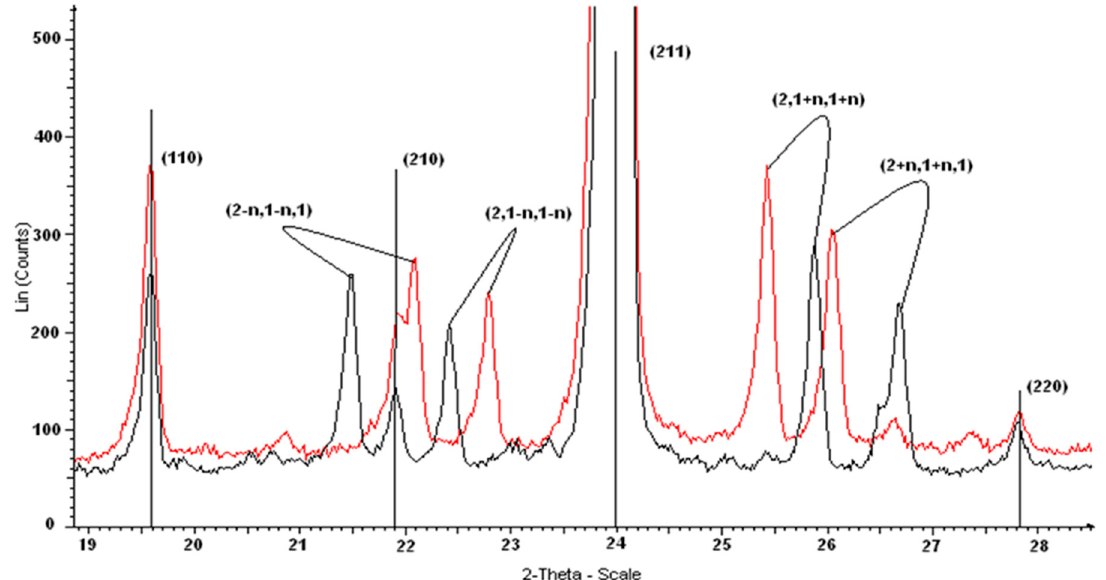
Figure 16. Fragments of the powder X-ray di ff raction patterns of the samples KL (upper curve) and MD (lower curve). The (1 1 0), (2 1 0), (2 1 1), and (2 2 0) reflections of these samples (indicated by vertical lines) have close d values because of close values of their cubic pseudo-cell parameters. Satellites having identical hkl indices with n (cid:44) 0 (those shown with curves) do not coincide because of di ff erent values of the n parameter (0.164 and 0.218, Table 3. Powder X-ray diffraction data of the MD sample.